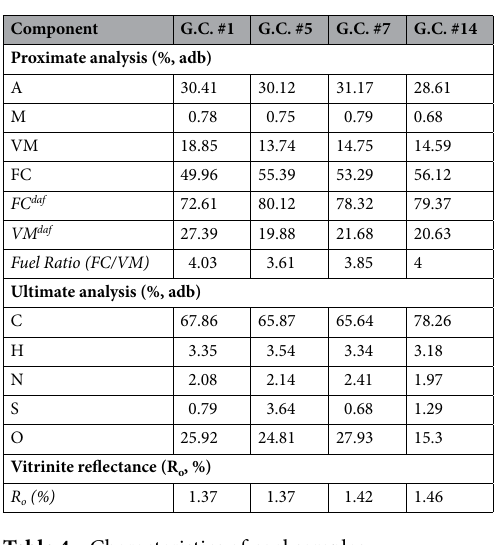
Table 4. Characteristics of coal samples.